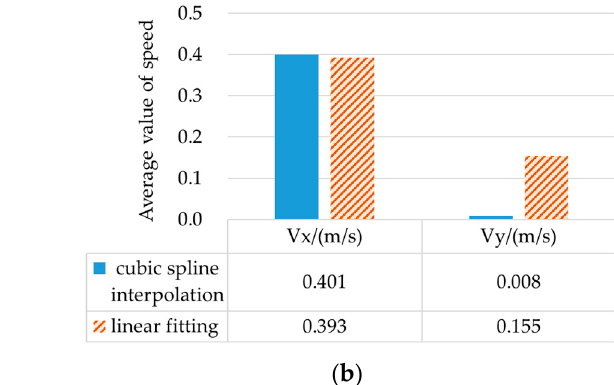
Figure 3. Average value of control variables and state variables in scenario 1 and scenario 2: ( a ) Average value of thrust and torque; ( b ) Average value of speed in x and y directions.